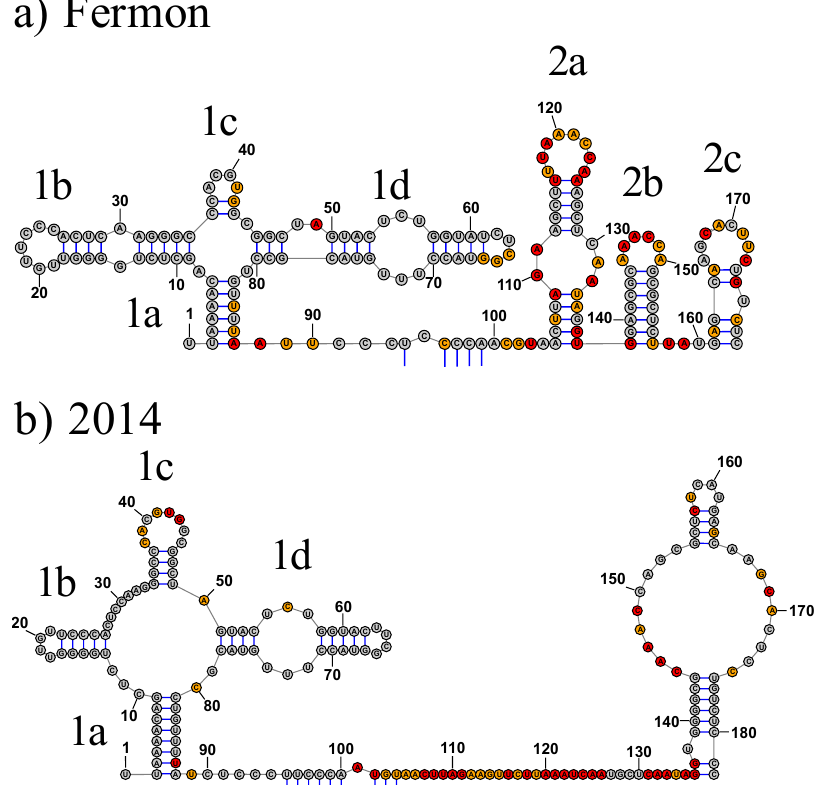
Figure 4. Secondary structure of domains I and II of EV-D68 5 ′ UTRs. ( a ) and ( b ) represent domains I and II of the 5 ′ UTR of the Fermon and 2014 strains of EV-D68, respectively. The shape reactivity of each nucleotide is indicated by colored shading. Grey shading indicates little reactivity, with reactivity values below 0.40. Orange shading indicates moderate reactivity, with reactivity values between 0.40 and 0.85. Red shading indicates high reactivity, with values greater than 0.85.